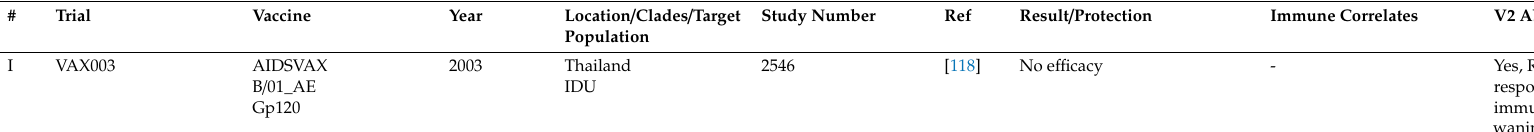
Table 2. Human HIV-1 vaccine e ffi cacy trials and